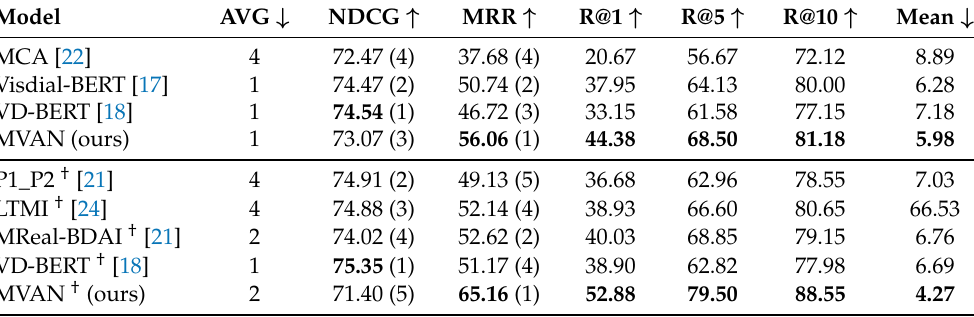
Table 3. Results of dense annotations fine-tuning on the VisDial v1.0 test-std dataset. † denotes ensembles. The models train with discriminative decoder are also used for ensembling.